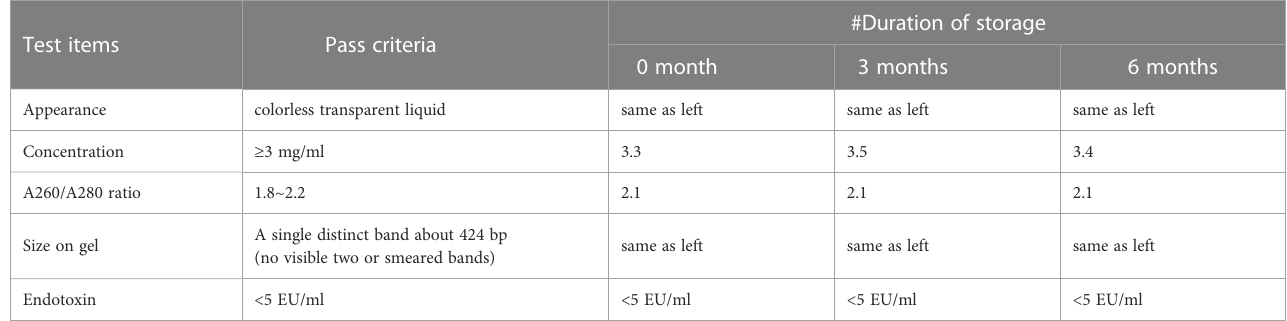
TABLE 2 An accelerated stability test of NVT